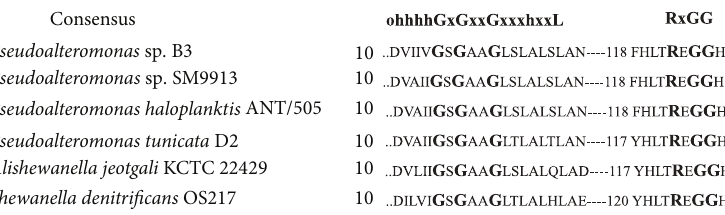
Figure 4: Sequence alignment between B3-LAAO and several homologous LAAOs. The highly conserved motifs, dinucleotide-binding domain motif ohhhhGxGxxGxxxhxxL for FAD binding where o stands for a polar or charged residue and h for a hydrophobic residue, and characteristic motif RxGG, are indicated.